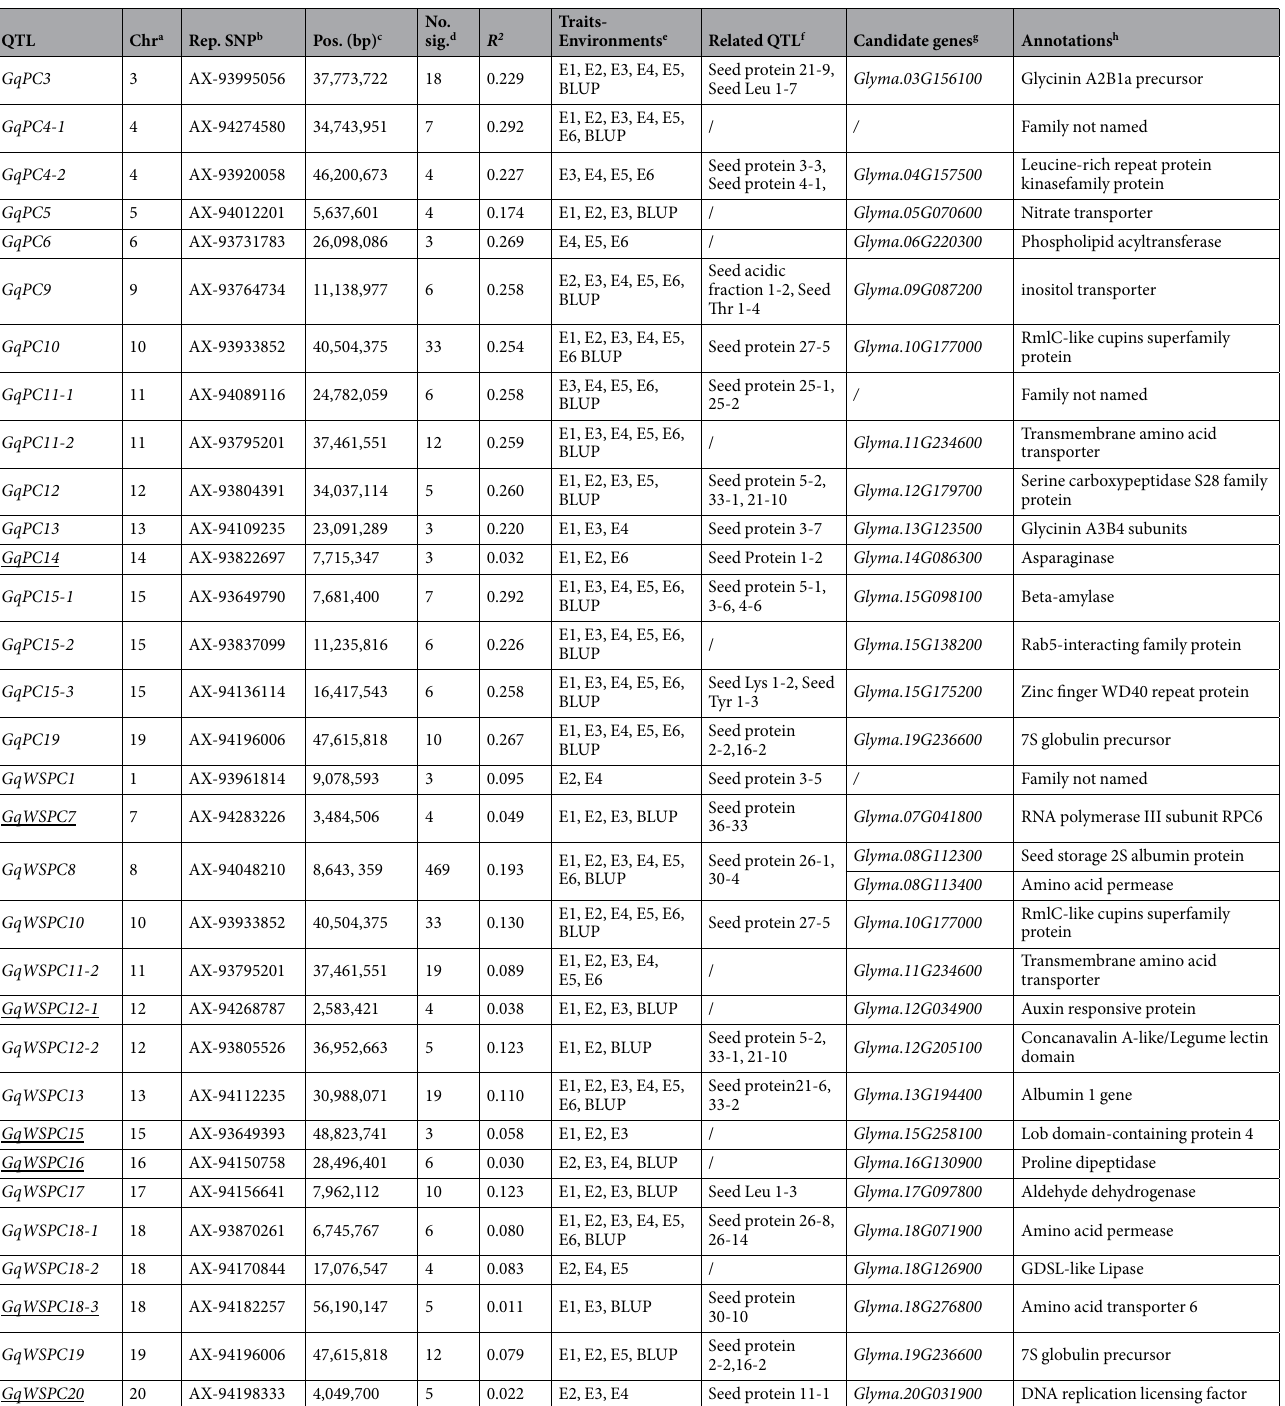
DNA replication licensing factor